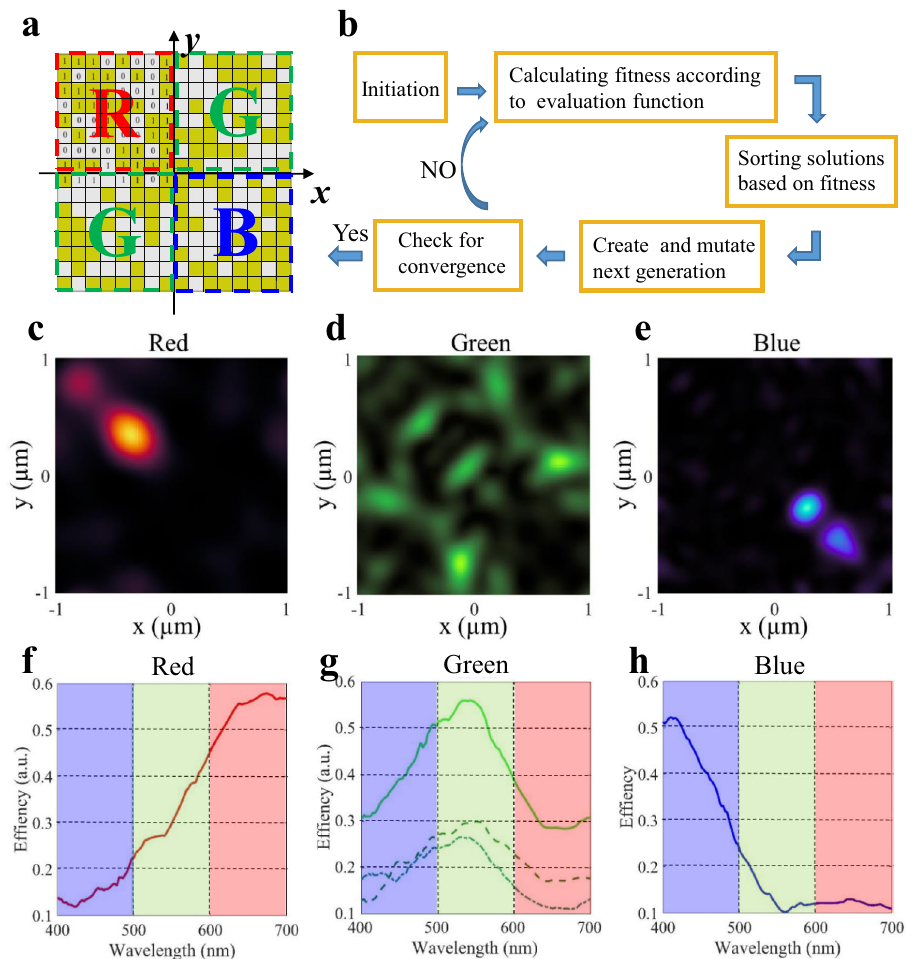
Fig. 2 The main design process and numerical simulation results. a Schematic of the prototype of binary-pattern MBCR. R, G and B represent the red, green and blue pixel area, respectively. b Flow diagram of the inverse-design progress with GA algorithm. c – e The calculated Poynting vector distributions of the transmitted light on the working plane for a unit-cell structure at 650, 540 and 450 nm, respectively. f – h The calculated optical transmittances in the visible spectrum of the four quadrants of the unit cell in MBCR. f , h correspond to the red and blue quadrant, respectively. In ( g ), two dotted curves correspond to the two green quadrants, while the solid line refers to the total energy collection ef fi ciency of the two